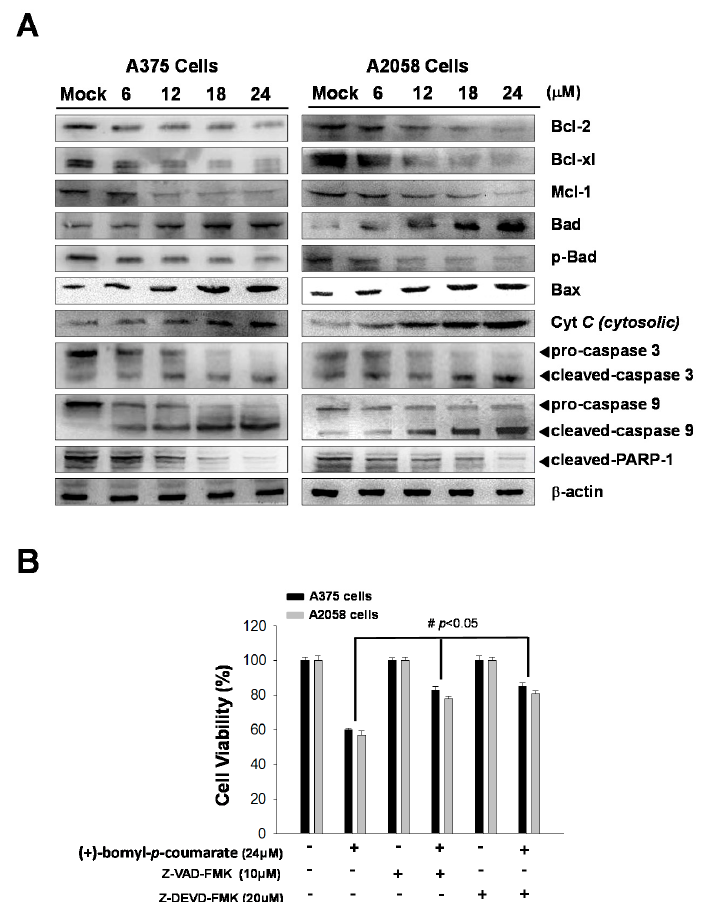
Figure 4. Mechanism of the caspase pathway in ( + )-bornyl p -coumarate-induced apoptosis, validated by western blot analysis and an inhibitor assay. ( A ) Western blot analysis showed changes in apoptosis-associated proteins in A2058 and A375 melanoma cells after treatment with ( + )-bornyl p -coumarate. ( B ) Inhibition of caspase-3 and caspase-9 suppressed ( + )-bornyl p -coumarate-induced cell death. Cells were pre-treated with / without Z-DEVD-FMK and Z-VAD-FMK for 2 h, then treated with 12 µ M ( + )-bornyl p -coumarate for 24 h. Cell viability was measured using an MTT assay. Data are presented as the means ± SD of at least three independent experiments. The results were analyzed using Student’s t -test ( # p < 0.05 compared with ( + )-bornyl p -coumarate treatment groups). Mock: cells treated with vehicle control